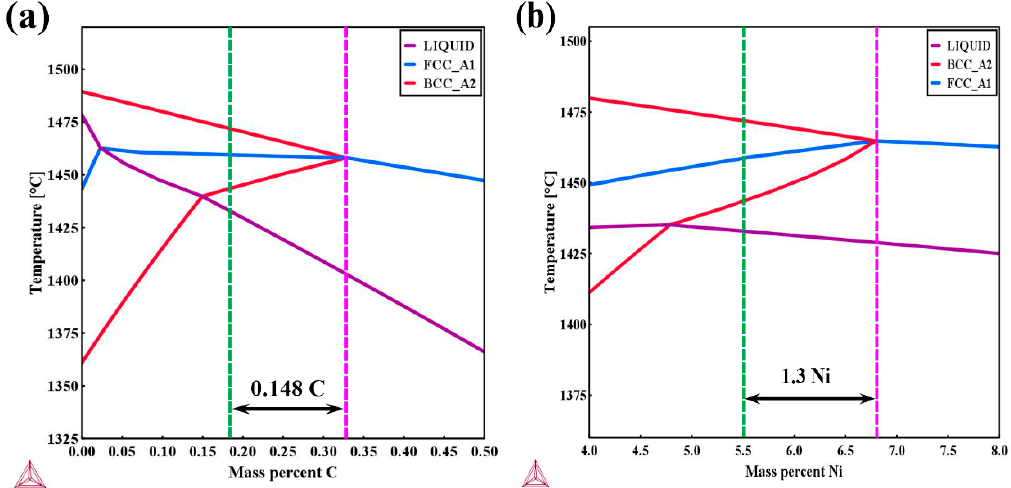
Figure 12. Thermo-calc calculation of solidification sequence of weld; ( a ) and ( b ) Solidification sequence of weld as a function of carbon and nickel content respectively .